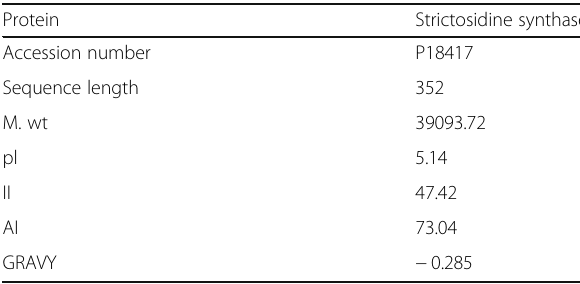
Table 4 Functional characterization of proteins of C. roseus at